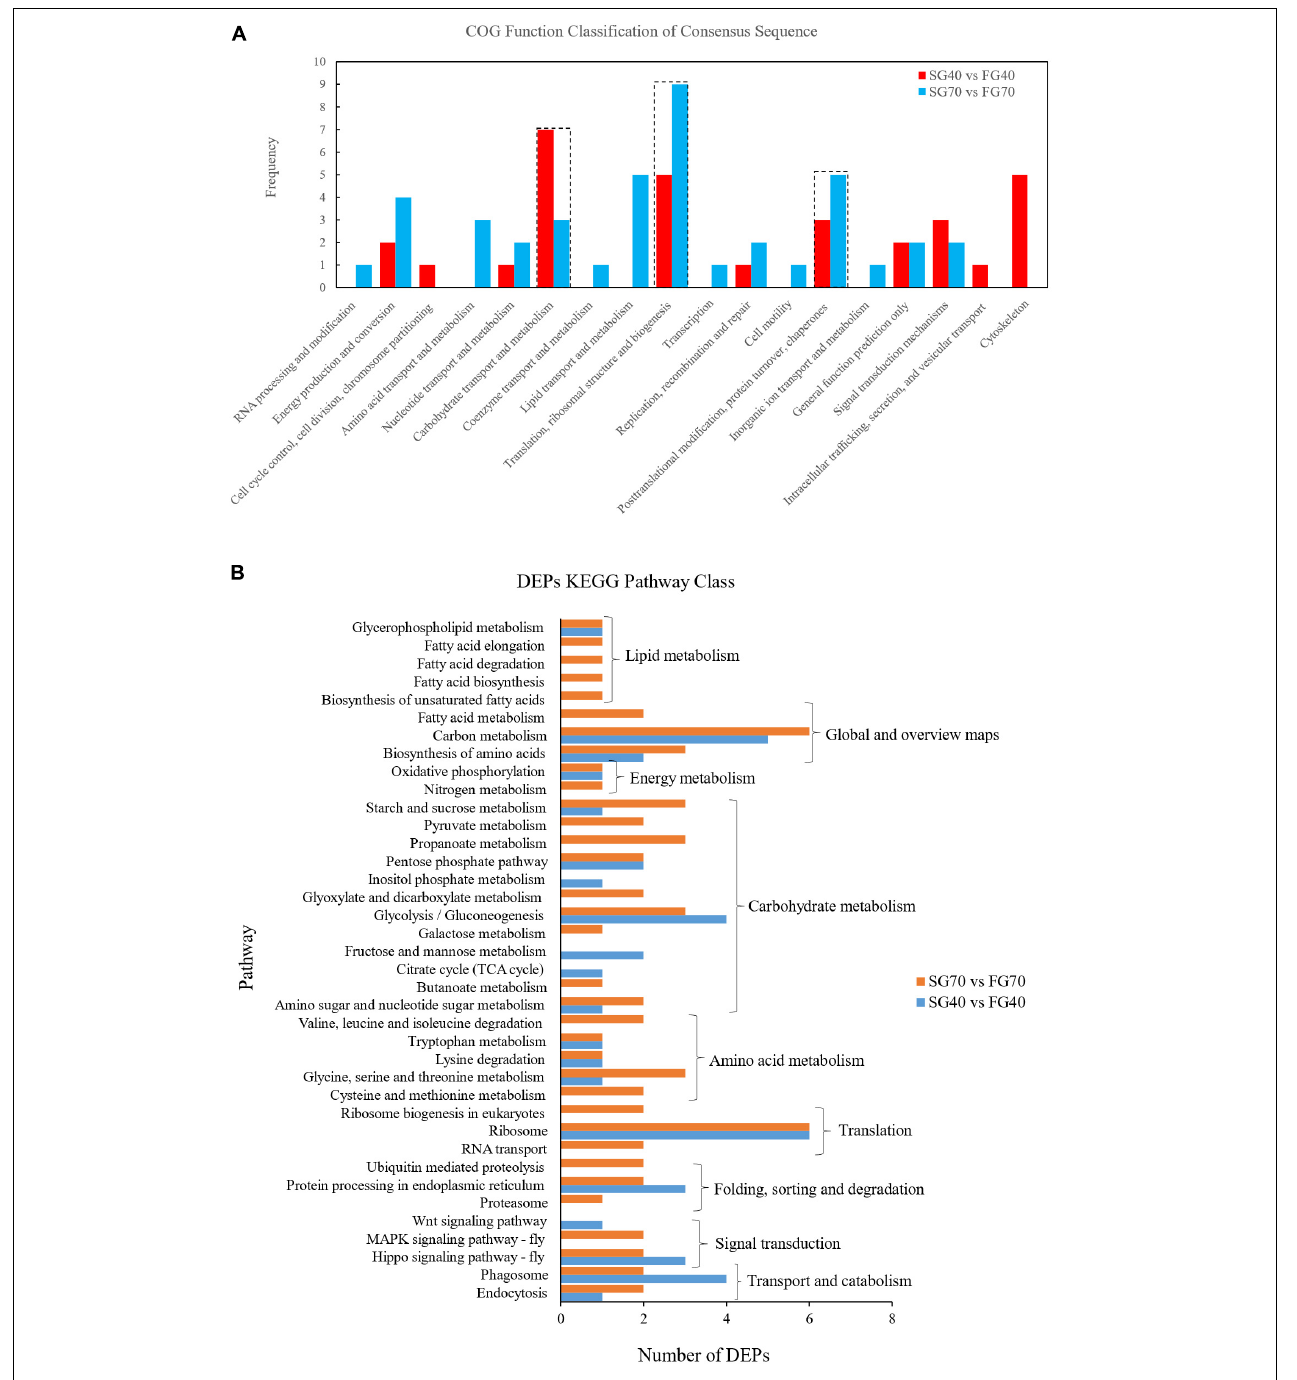
FIGURE 4 | COG and KEGG analysis of the DEPs in M. japonicus . (A) COG analysis and (B) KEGG analysis.